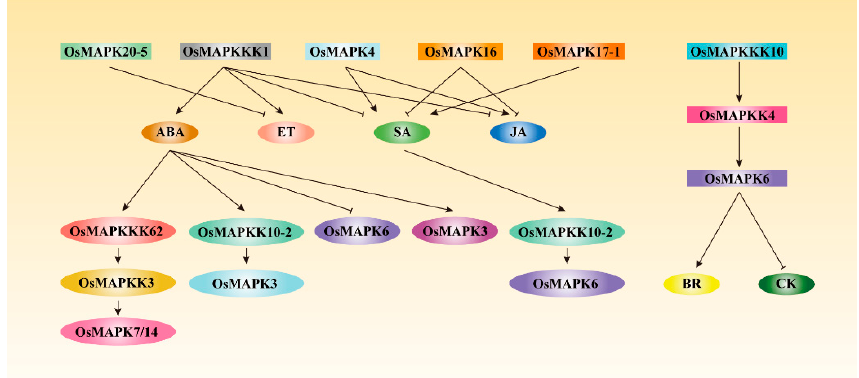
Figure 4. Rice MAPK cascades regulate or are involved in phytohormone accumulation, signal transduction or response. Rice MAPK cascades positively or negatively regulate phytohormone accumulation and signal transduction, or been directly or indirectly modulated by phytohormones, such as SA, JA, ABA, ET, BR, and CK [12–15,27,28,40,43,48,49]. The established OsMAPKKK62-OsMAPKK3-OsMAPK7/14 cascades are regulated by ABA, while the OsMAPKKK10-OsMAPKK4-OsMAPK6 cascade can regulate BR and CK signal transduction [17–19,24].